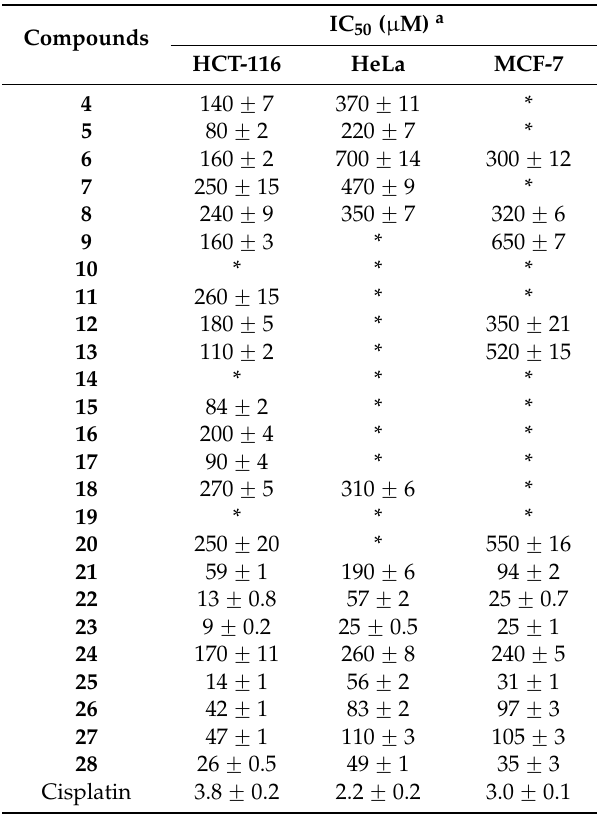
Table 1. Cytotoxicity of compounds 4 – 28 toward human cancer cell lines